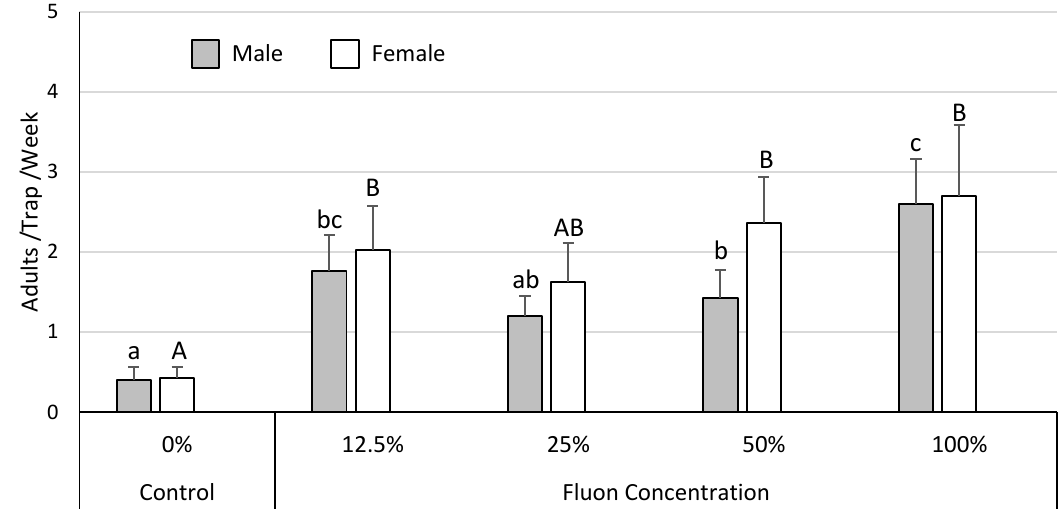
Figure 2. The addition of fluon increased trap capture of L. zonatus. Columns of the same color without a common letter differ significantly.